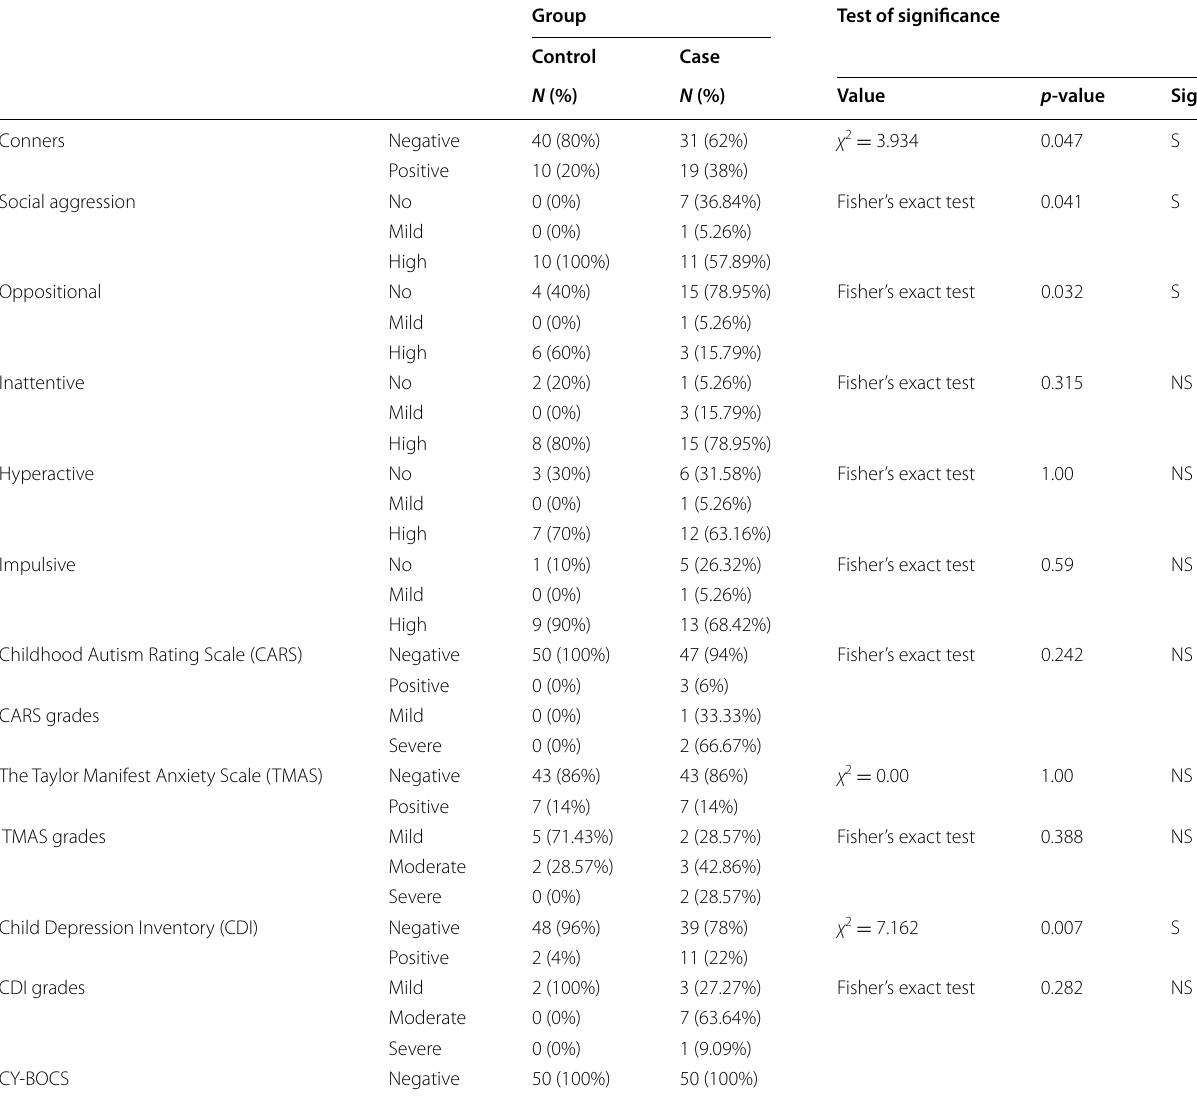
Chi-square test of significance ( χ 2